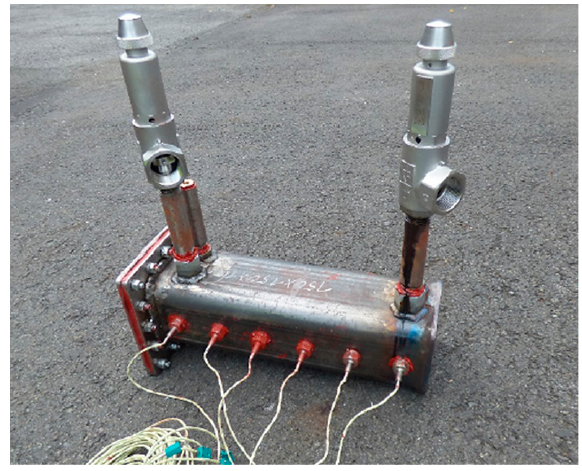
Figure 12. Apparatus schematic.